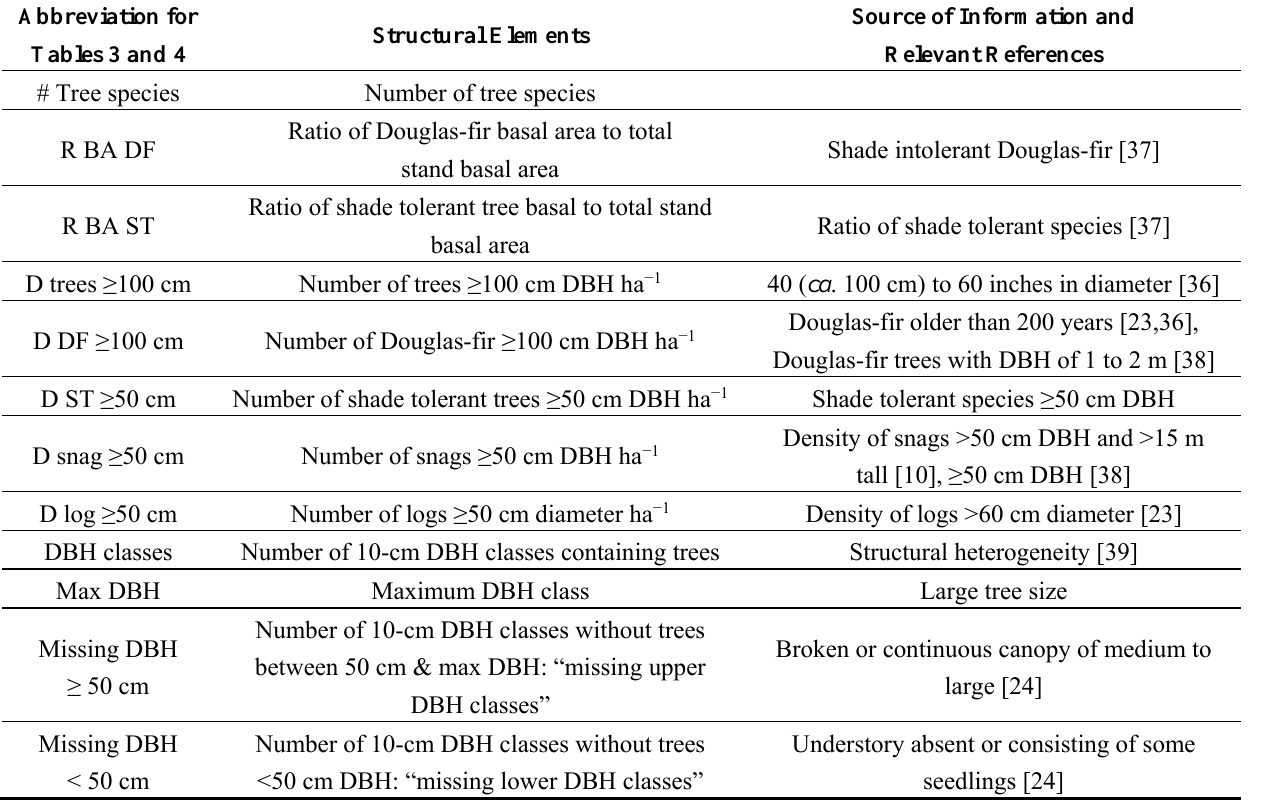
Table 2. Quantitative structural variables used for old-growth characteristics in this study, modified from previous